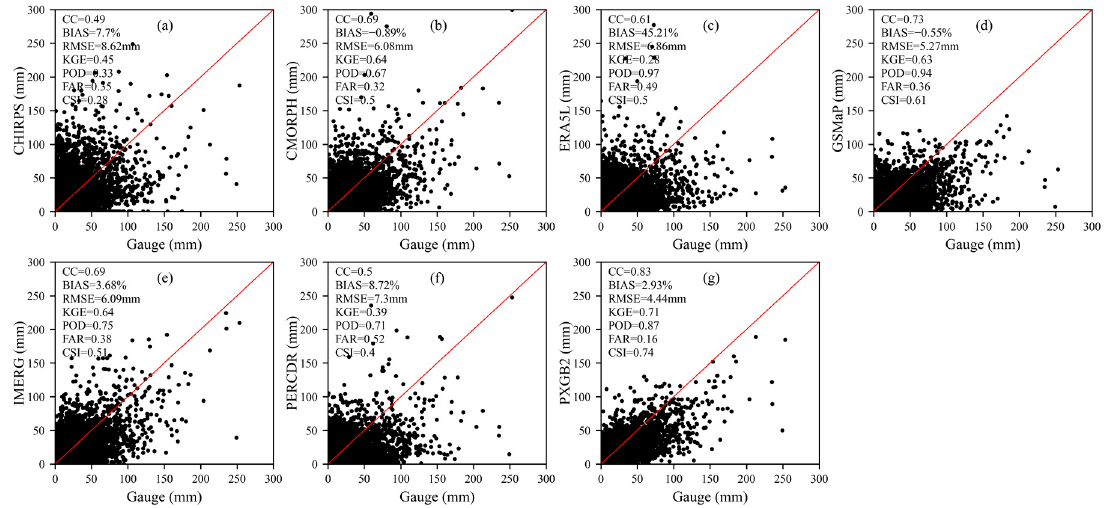
Figure 2. Scatterplots of the daily precipitation between Gauge and seven products at the grid scale. The red line is the 1:1 reference line. ( a ) is CHIRPS, ( b ) is CMORPH, ( c ) is ERA5L, ( d ) is GSMaP, ( e ) is IMEGR, ( f ) is PERCDR, ( g ) is PXGB2.